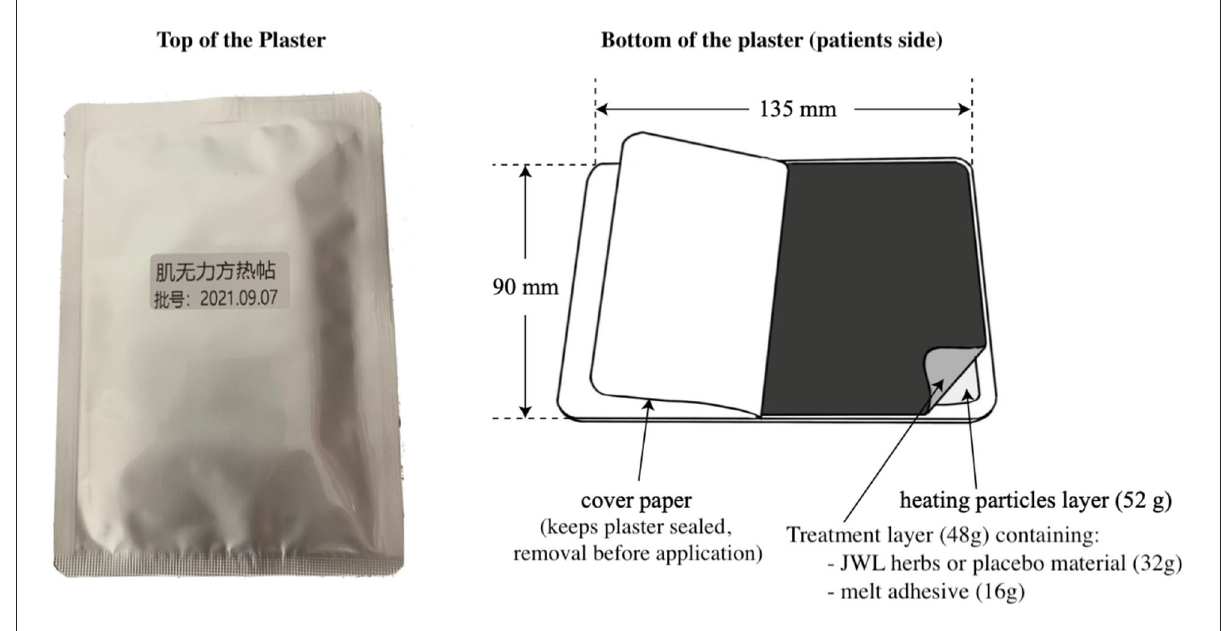
FIGURE1 The layers of the Ji-Wu-Li plaster and the